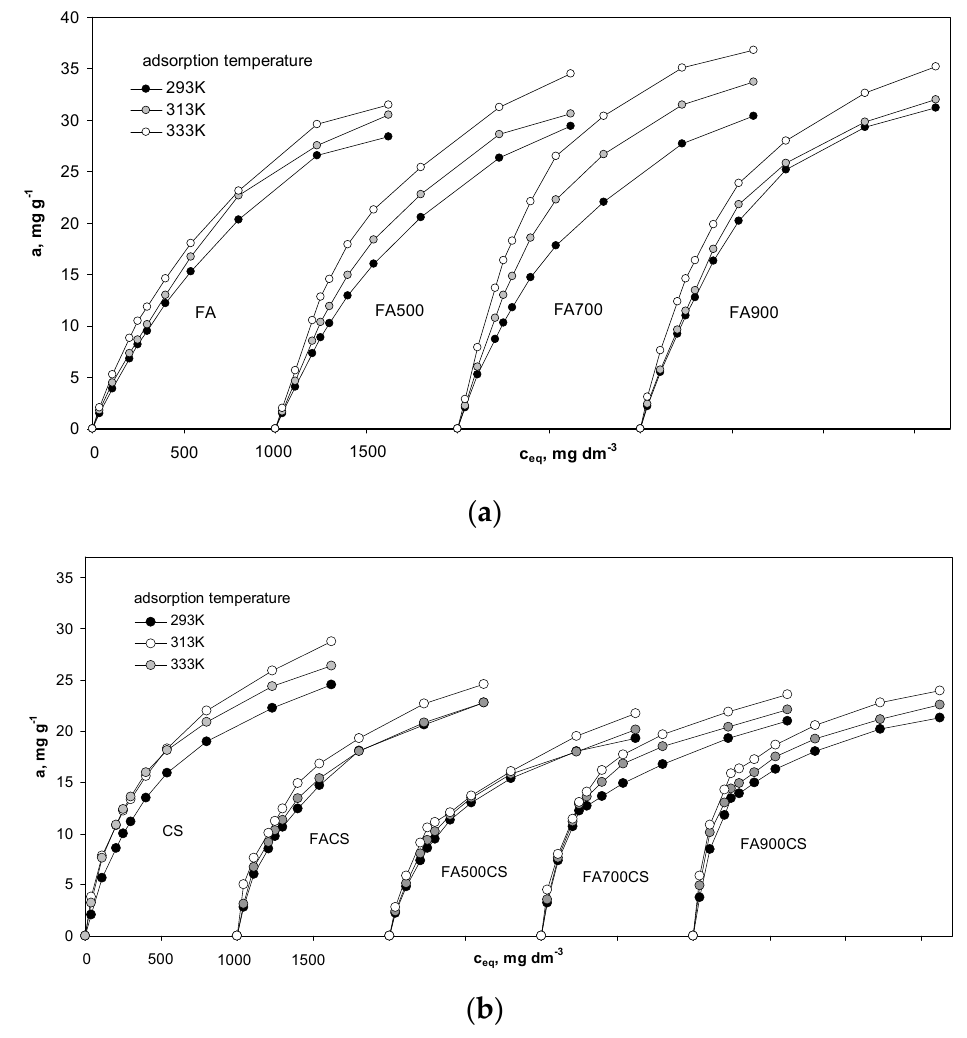
Figure 7. As(V) adsorption isotherms at pH = 6, at various temperatures on: fly ash ( a ); chitosan and chitosan modified fly ash ( b ). The scale bar on the c eq axis drawn only for the first three isotherms (FA group in the upper plot and CS group in the lower plot) is valid for the next adsorbents when shifted against the c eq axis to meet a = 0 point for any isotherm (it means that all curves start from zero concentration). The error bars are practically covered by the labels of the experimental